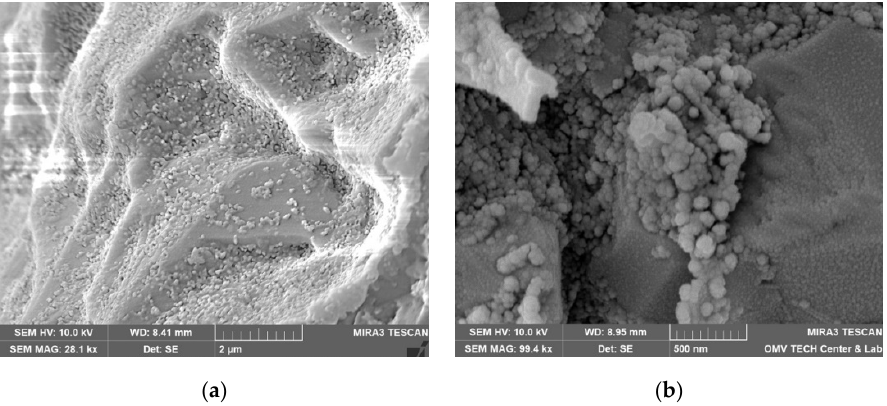
Figure 22. Scanning electron microscope (SEM) images measured for the core material used in this work. The image ( a ) shows a rock sample that has been vacuum saturated, whereas the image ( b ) shows a core flood sample. Both samples have been treated with 1 wt% nanofluid A in test water. Bigger particle structures can be seen on the core flood sample.